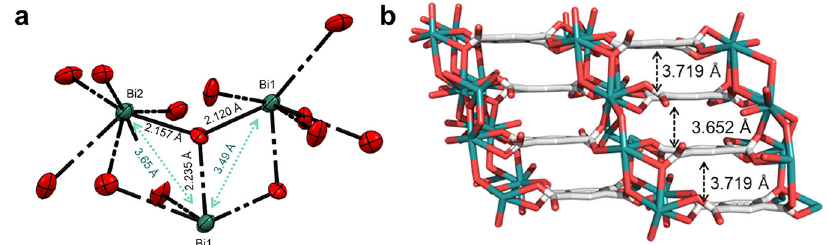
Fig. 1 Crystal structure of Bi-BTCA. a ORTEP view of the bismuth coordination geometry with 50% thermal ellipsoids. b Network having a 3D parallel packing structure along the b direction with a face-to-face stacked orientation. Although hydrogen atoms are omitted here for clarity, they were considered in the calculation of the accessible volumes. Green, bismuth; gray, carbon; red,